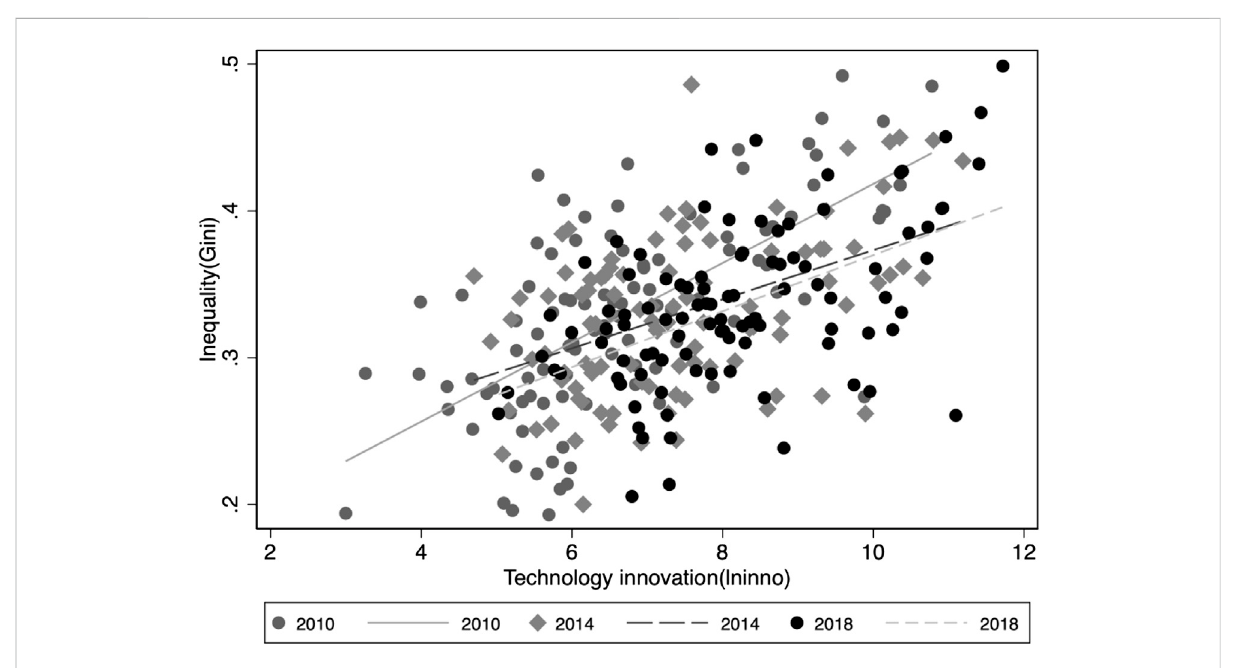
FIGURE 2 Gini coef fi cient and technological innovation (2010, 2014, and 2018) 2